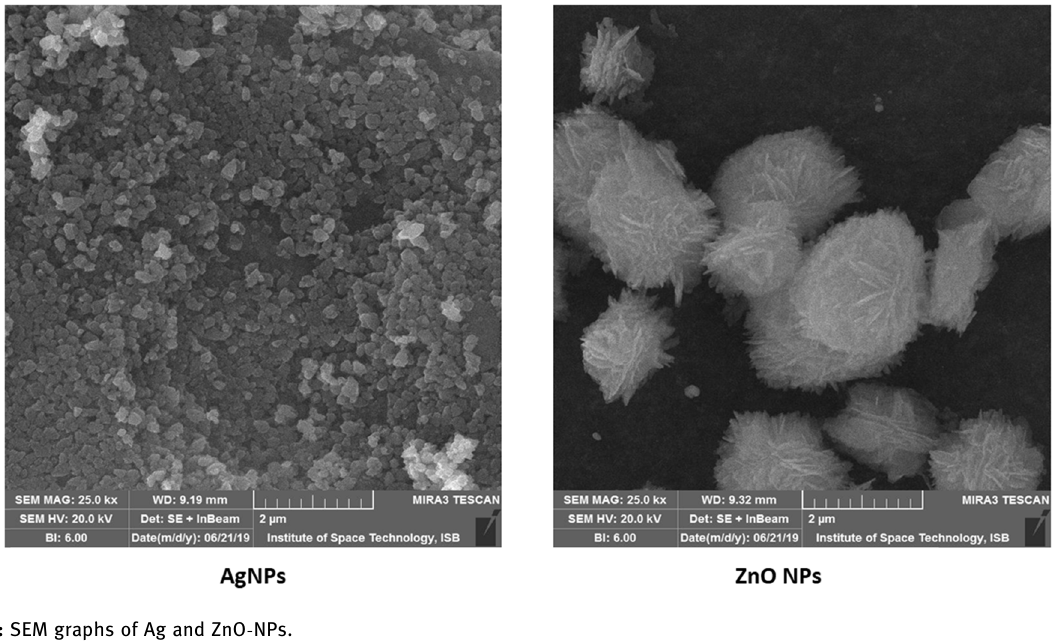
Figure 6: SEM graphs of Ag and ZnO - NPs.